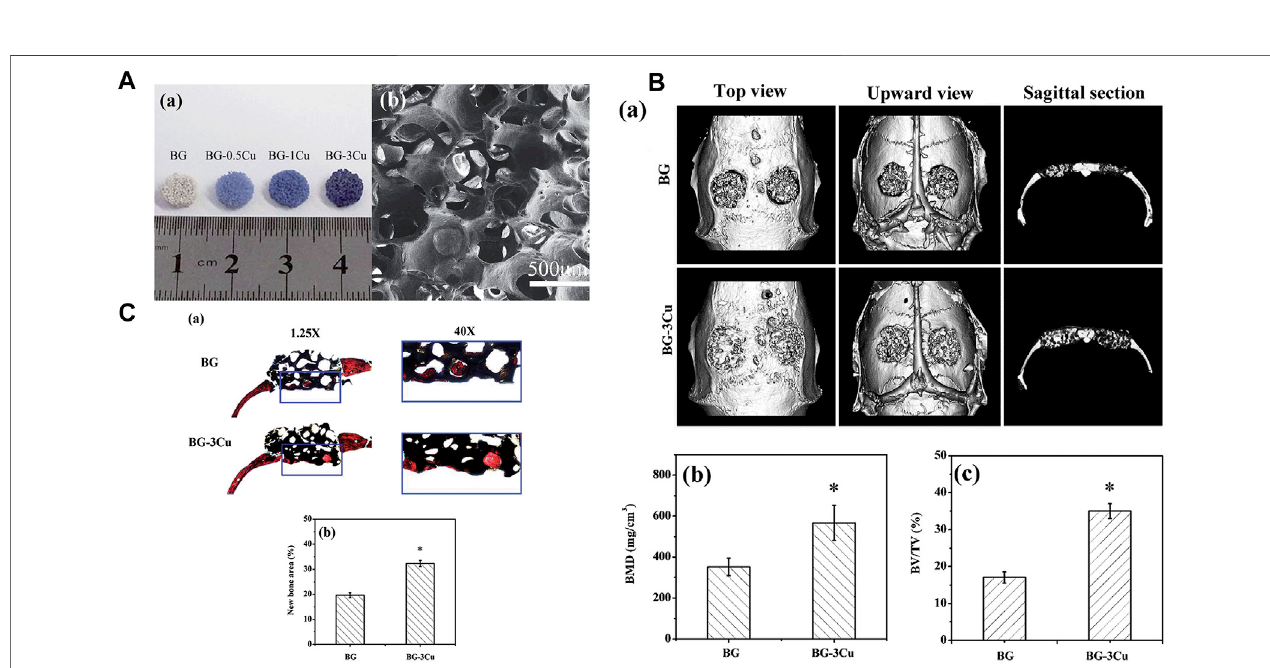
FIGURE 2 | (A) Optical images and SEM images of the scaffolds were obtained. (B) Microct evaluation of skull defects and un fi lled bone regeneration in rats implanted with BG-3Cu and BG stents 8 weeks after implantation. (C) Transmitted light images of stained sections of rat skull defects implanted with BG-3Cu and BG scaffolds and un fi lled defects 8 weeks after implantation. Reprinted with permission from ref. (Wang et al., 2014). (Copyright 2014; The Royal Society of Chemistry).